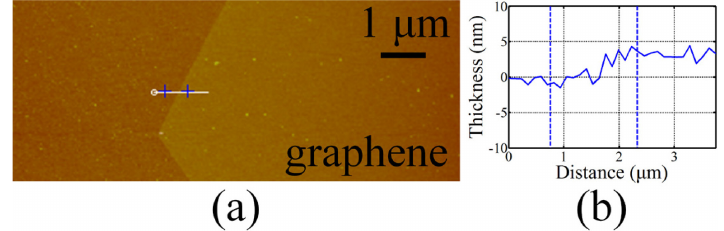
Figure 2. ( a ) Height image of the graphene in AFM tapping mode and ( b ) height analysis trace along the white line in ( a ).